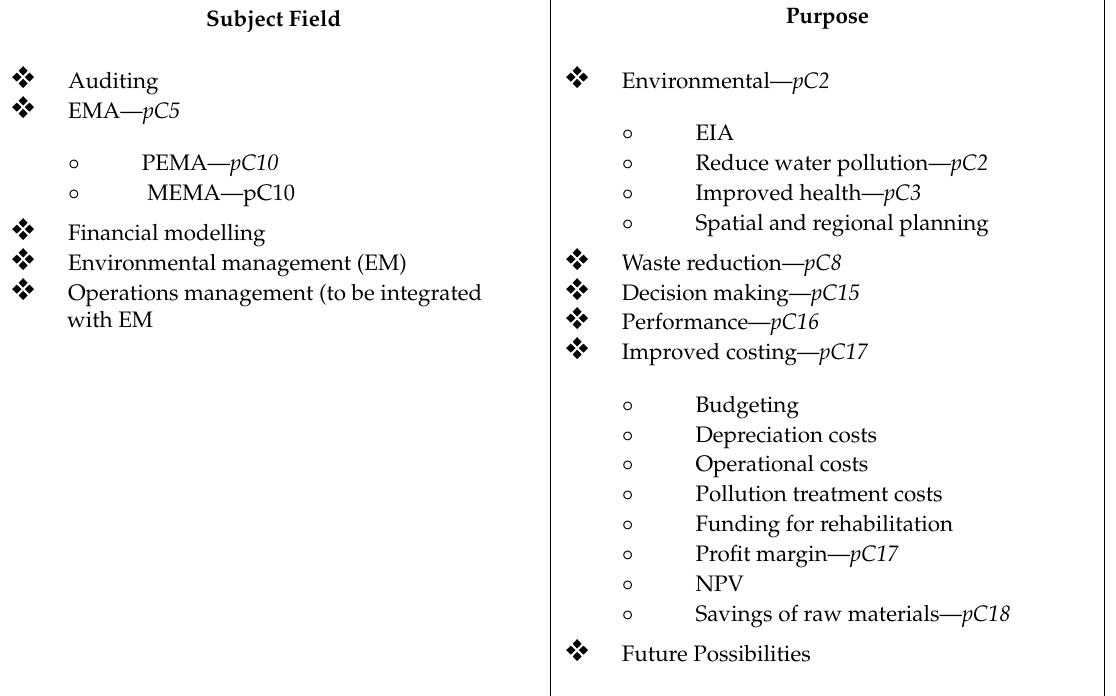
Table 5. Enhanced entities from